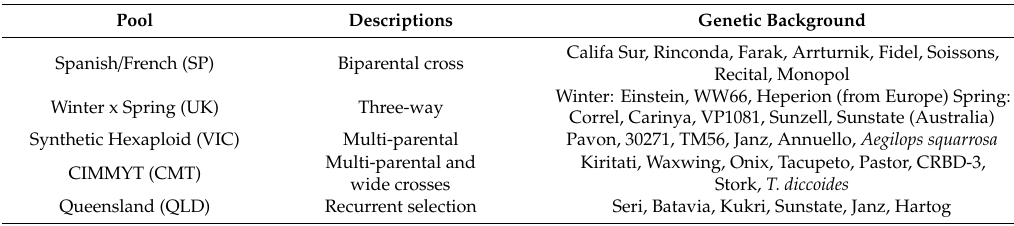
Table 2. List of the parents in di ff erent gene pools.